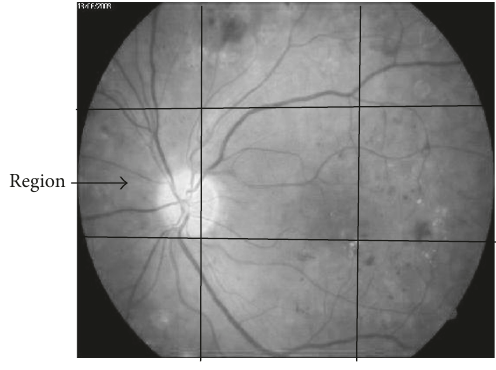
Figure 2: Nonoverlap sliding window.